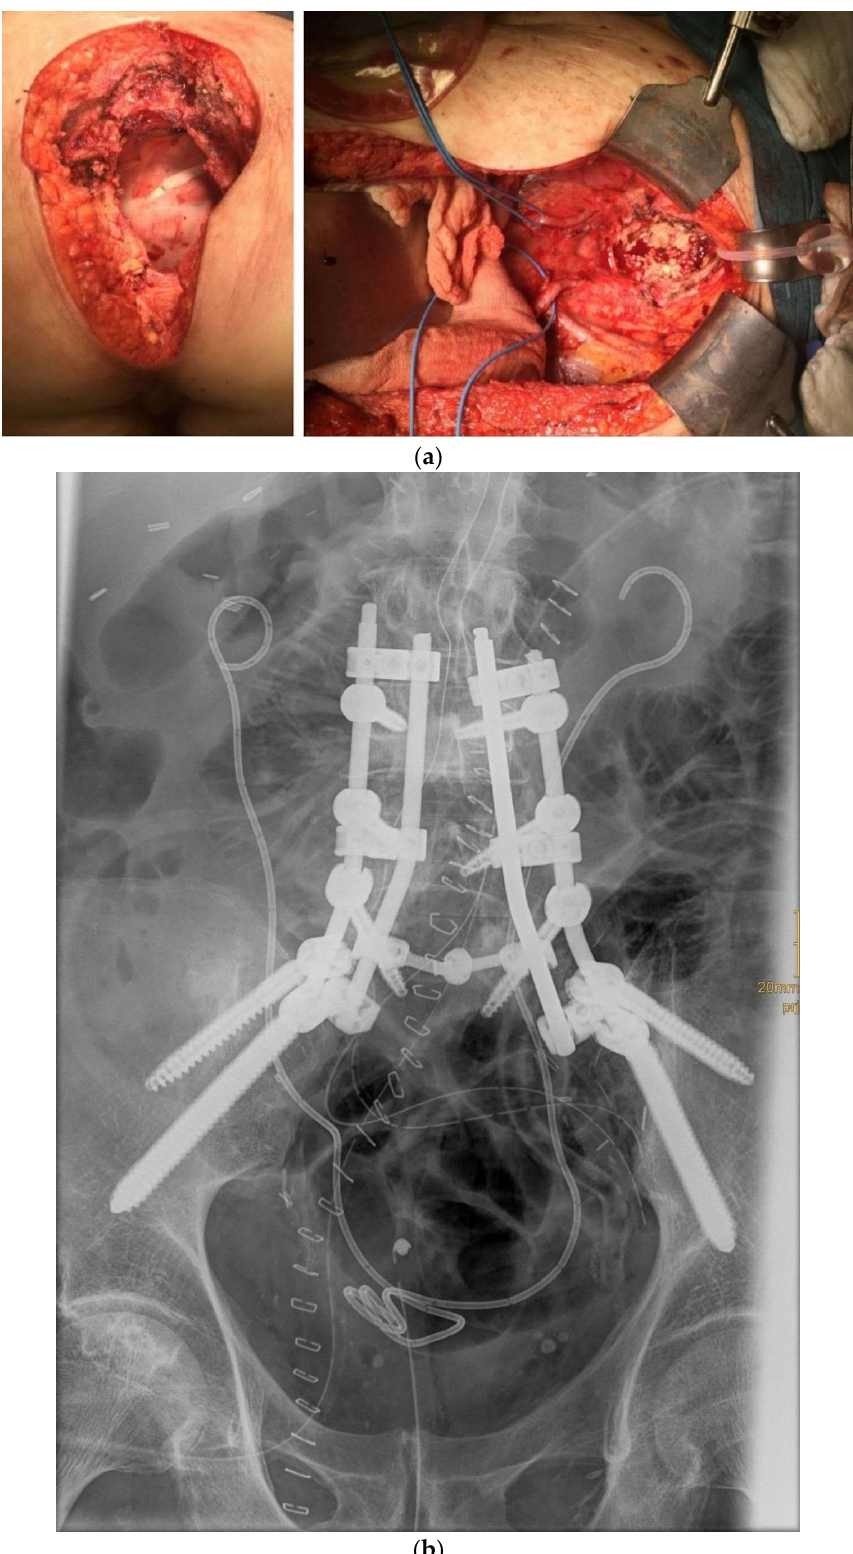
Figure 2. ( a ) Recurrent rectal carcinoma with infiltration of the os sacrum (surgeons: B. Lampe and D. Frank), ( b ) Recurrent rectal carcinoma with infiltration of the os sacrum; postoperative X-ray overview after stabilisation (surgeons: J. Weitz/K-D. Schaser).